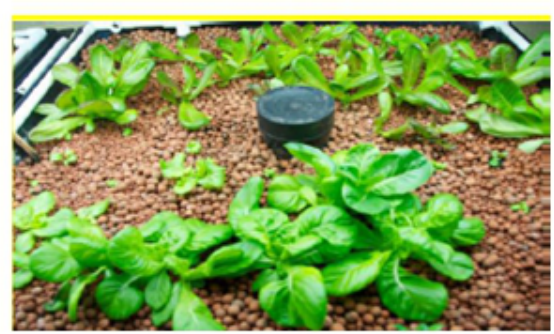
Figure 3. Grow bed with clay pebbles (Japan Aquaponics,